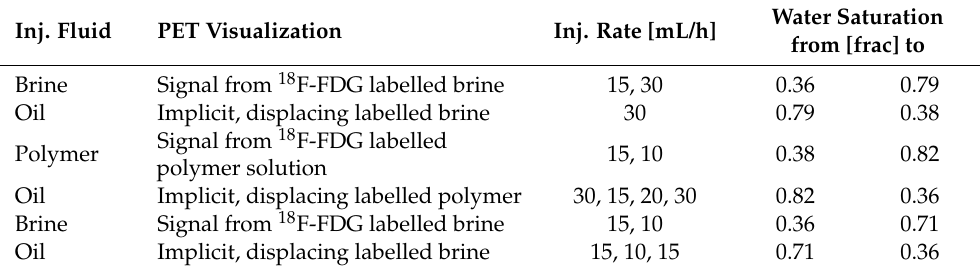
Table 3. Experimental schedule during PET imaging. Note that PET imaging only detects radioactive signal and cannot give information about initial saturation distribution or fluid affinity (wetting). The mobile saturation interval remained relatively stable between